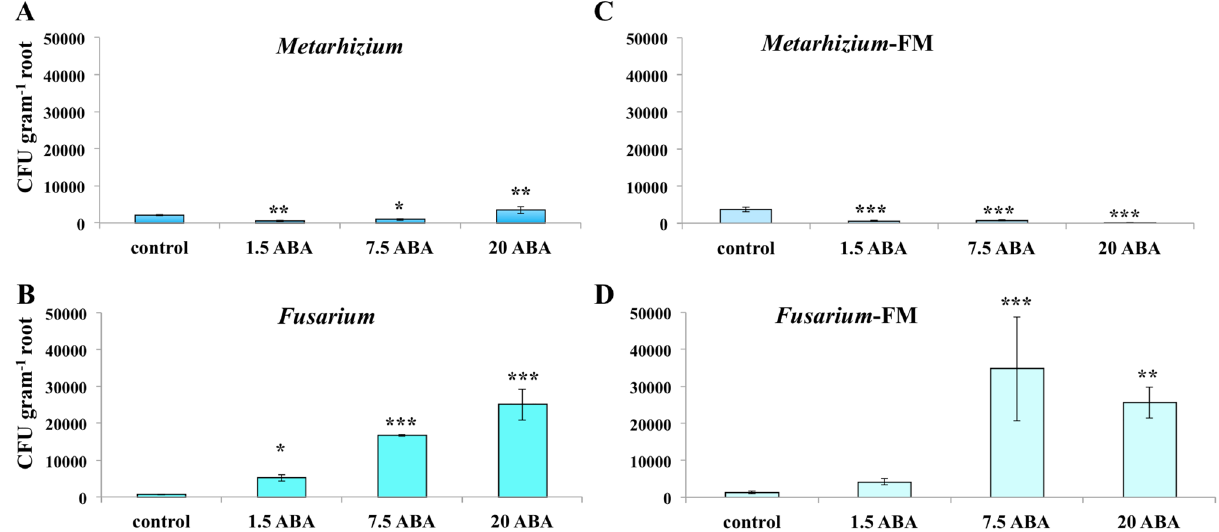
Figure 2. CFU of M. robertsii or F. solani in bean root homogenate after exogenous application of ABA. X-axis represents values of ABA μg per bean plant. FM: F. solani and M. robertsii treatment group. Standard error bars are shown. Data were analyzed by one-way ANOVA with Fisher’s least-significant difference (LSD) test. Statistical differences shown; Asterisks indicate statistically significant differences relative to corresponding fungus colonized plant without ABA application * P < 0.05, ** P < 0.01, *** P <